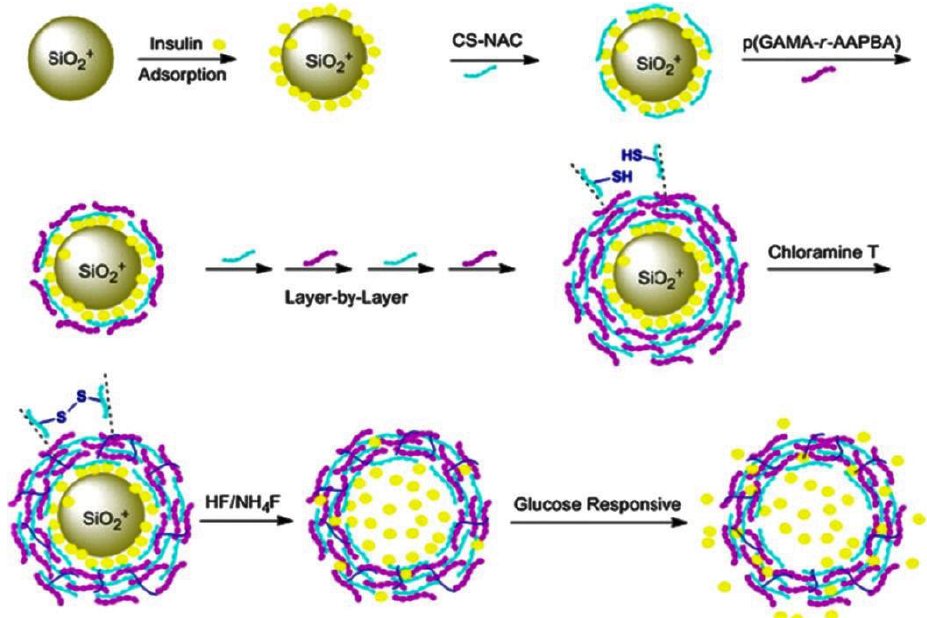
Figure 4. Preparation of glucose-responsive multilayer particles via the LbL process. Reprinted from [35], with permission from Springer Science and Business Media.